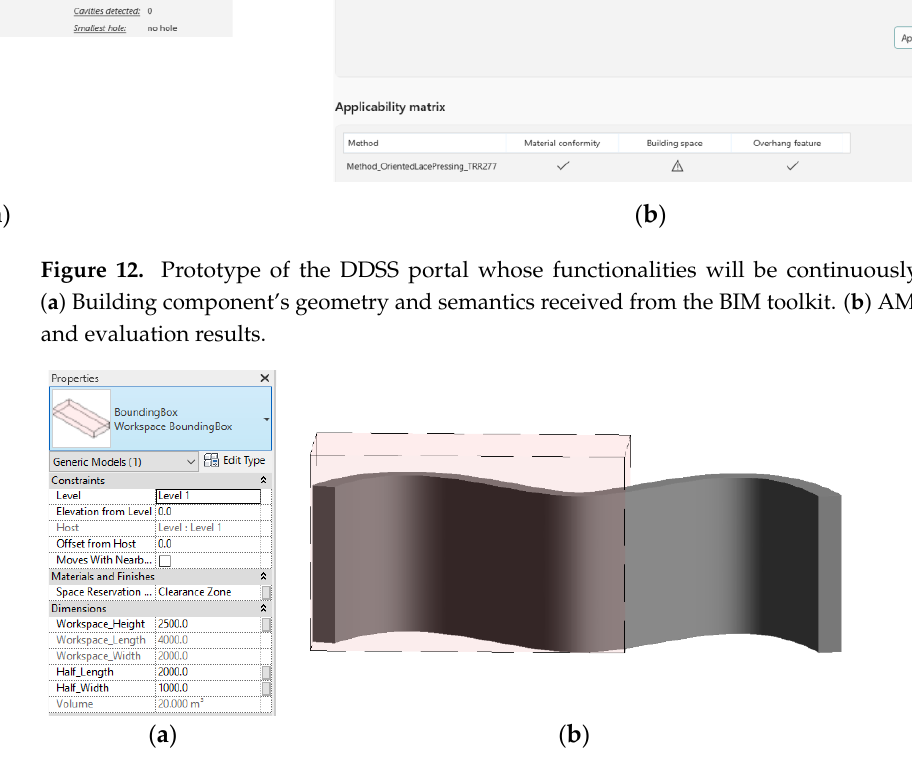
Figure 13. Visualization of dimensional disconformity — machine system ’ s workspace is smaller than the dimension of a single curved wall. ( a ) A parametric Revit family represents the workspace and is controlled by the BIM toolkit. ( b ) The workspace is automatically positioned and oriented on the curved wall.